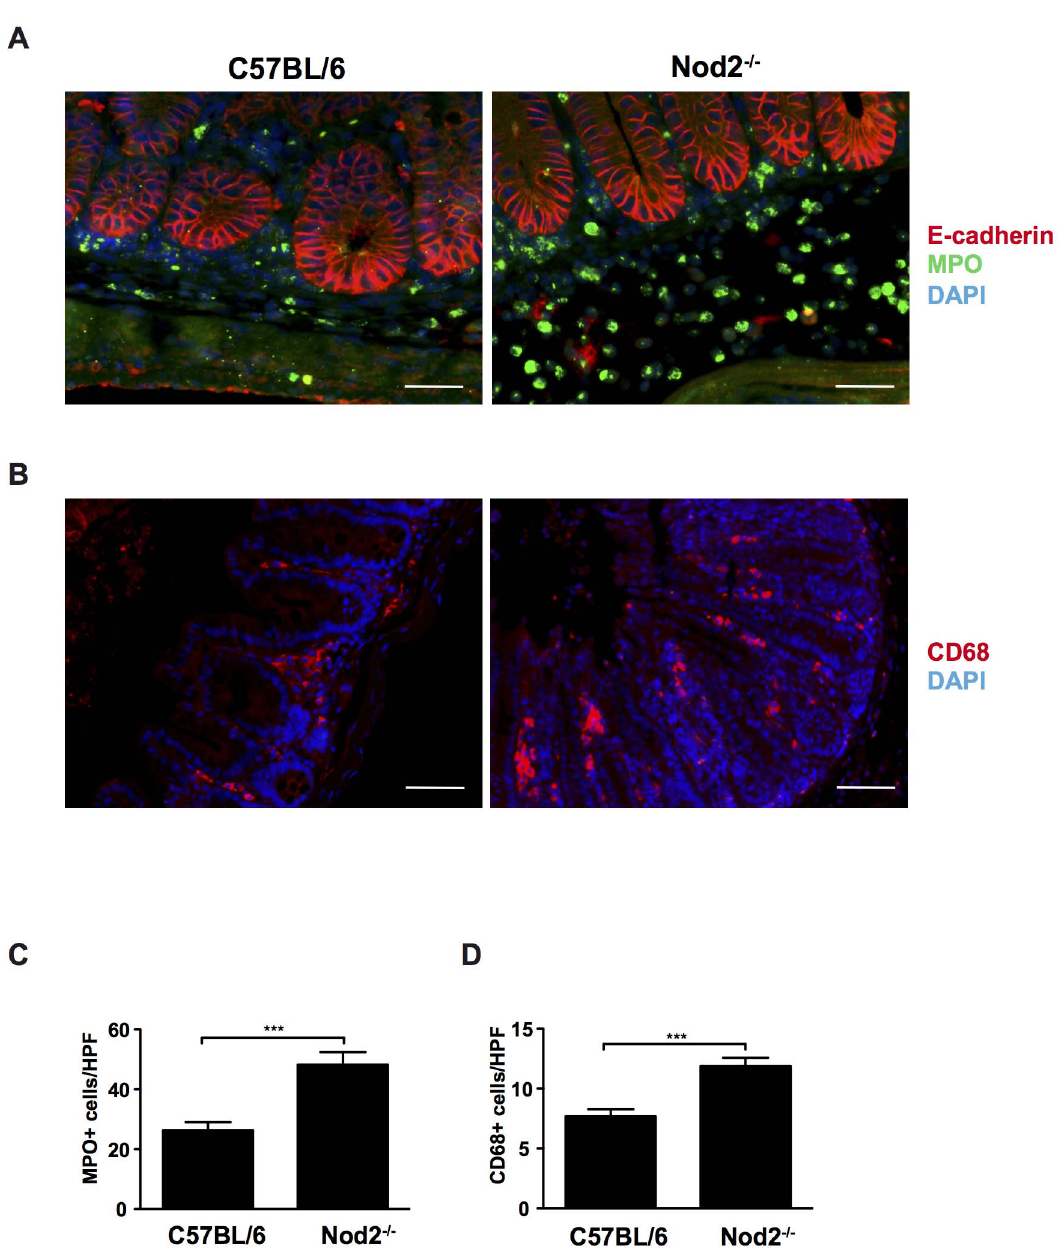
Figure 2. Increased early influx of neutrophils and macrophages in Nod2 2 / 2 mice. Streptomycin-pretreated C57Bl/6 and Nod2 2 / 2 mice were orally infected with S. Typhimurium D msbB for 2 days and cecum sections were stained to visualize neutrophils and macrophages, respectively. (A) Cecum sections were stained for DAPI (blue), E-cadherin (epithelial cells, red) and MPO (neutrophils, green). (B) Cecum sections were stained for DAPI (blue) and CD68 (macrophages, red). Original magnification: 400 6 , scale bars 5 50 m m. (C) Quantification of MPO + and (D) CD68 + cells. HPF 5 high power field. Statistical analysis: Student’s t test. *** p ,